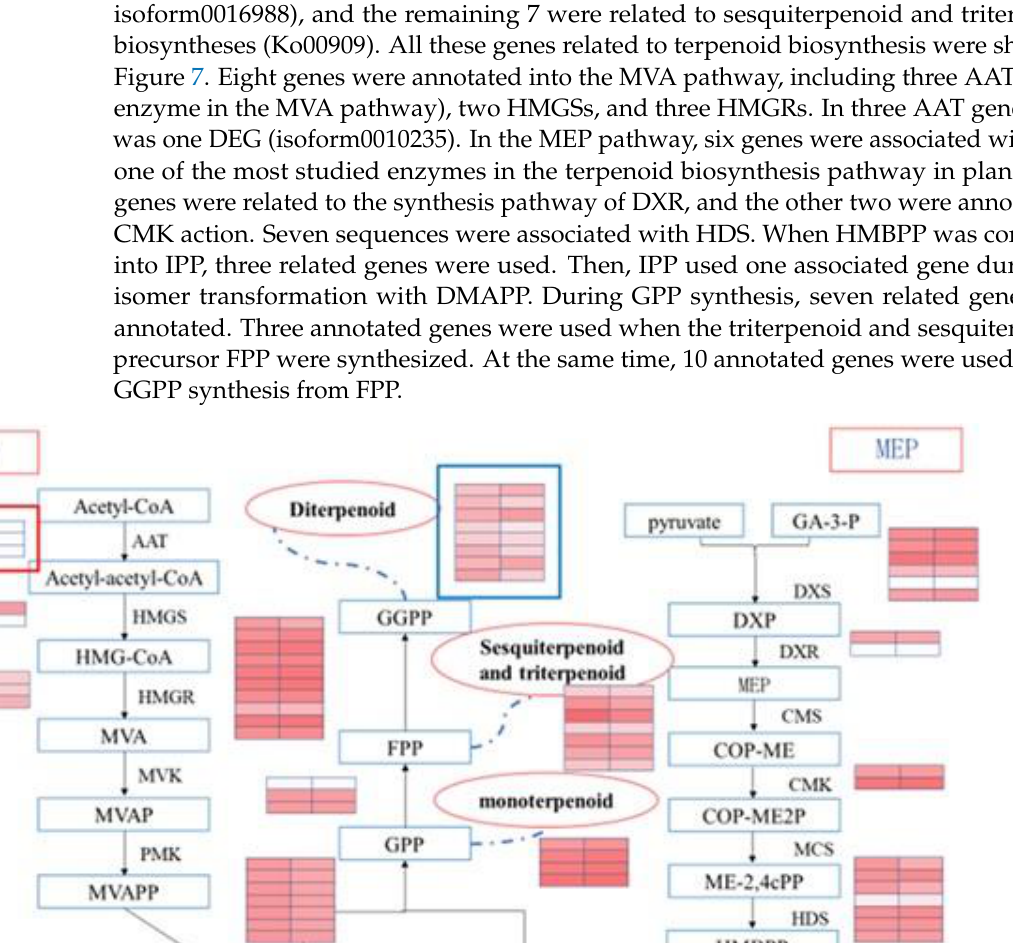
Figure 6. Bubble diagram of KEGG enrichment on differentially expressed genes.